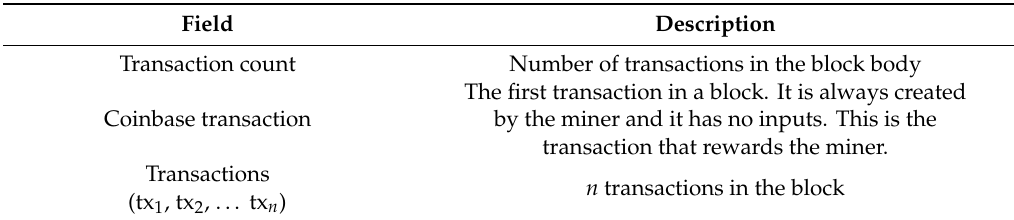
Table 2. Structure of the body in the block.